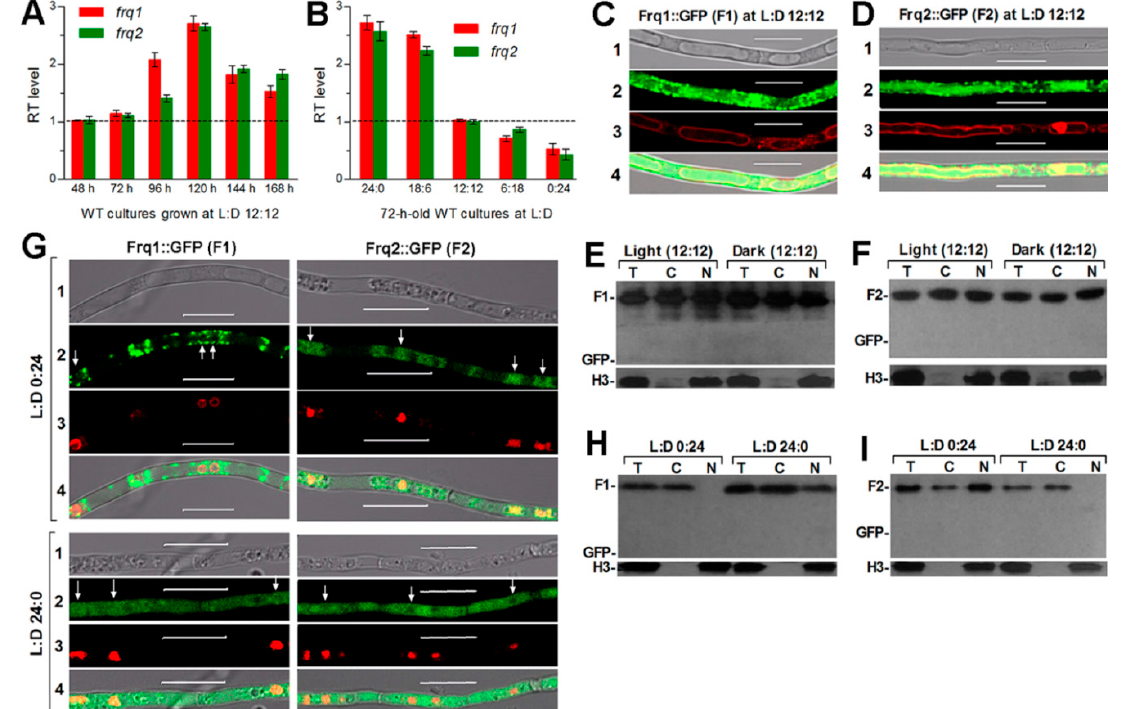
Figure 1. Transcriptional expression and subcellular localization of Frq1 and Frq2 in B. bassiana . ( A , B ) Relative transcript (RT) levels of frq1 and frq2 over the time (h) of cultivation at the optimal regime of 25 ◦ C and L:D 12:12 with respect to the standard at 48 h and in the 72-h-old cultures grown in di ff erent L:D cycles with respect to the standard at L:D 12:12, respectively. All WT cultures were initiated by spreading 100 µ L aliquots of a 10 7 conidia mL − 1 suspension on SDAY plates. Error bars: SD from three cDNA samples analyzed via qPCR with paired primers (Table S1). ( C , D ) Laser scanning confocal microscopic (LSCM) images (scale = 10 µ m) for subcellular localization of Frq1::GFP (F1) and Frq2::GFP (F2) in transgenic hyphae, which were collected from the 72-h-old cultures of a 10 6 conidia mL − 1 suspension in SDBY shaken at 25 ◦ C and L:D 12:12 and stained with the membrane-specific dye FM4-64. ( E , F ) Western blots for F1 (131.8 kD) and F2 (92.7 kD) detected by anti-GFP antibody in total (T), cytoplasmic (C) and nuclear (N) protein extracts, which were isolated from the 72-h-old SDBY cultures of transgenic strains taken near the end of light or dark hour at L:D 12:12. ( G ) LSCM images (scale = 10 µ m) for subcellular localization of F1 and F2 in the hyphae collected from the 72-h-old SDBY cultures at L:D 0:24 and L:D 24:0, respectively, and stained with the nuclear dye DAPI. ( H , I ) Western blots for F1 and F2 in the protein extracts isolated from the SDBY cultures grown at L:D 0:24 and L:D 24:0, respectively. Rows 1 − 4 in C, D, and G denote bright, expressed, stained, and merged views of the same field. Arrows in C indicate locations of nuclei. Each lane in E, F, H, and I was loaded with 60 µ g protein extract. Nuclear standard: histone H3 probed by anti-histone H3 antibody. Note that GFP alone (27 kD) is undetectable with the anti-GFP antibody, indicating a fusion of Frq1 or Frq2 to GFP as expected.